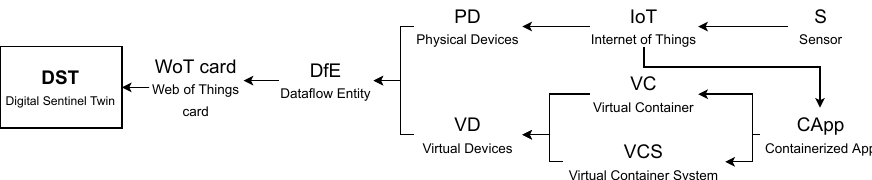
Figure 2. Conceptualization of a DST